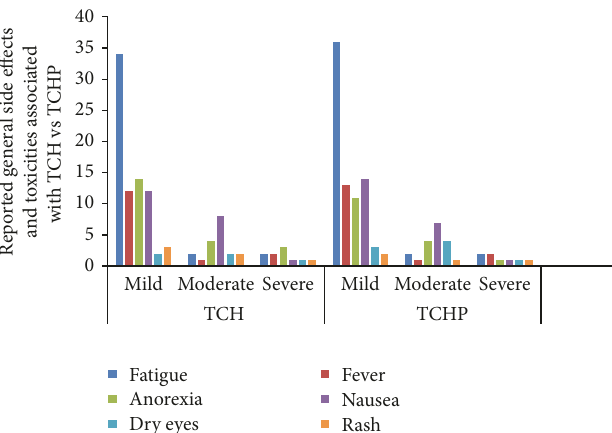
Figure2:ReportedgeneralsideeffectsandtoxicitiesassociatedwithTCH(docetaxel,carboplatin,andtrastuzumab)versusTCHP(docetaxel, carboplatin, trastuzumab, and pertuzumab). The most common toxicities documented in the patient records by severity are shown. Numbers indicate percentages of patients with documented evidence of specific adverse toxicities. The severity of side effects was established according to Common Terminology Criteria for Adverse Events (CTCAE), Version 4.0, June 2010, National Institutes of Health, National Cancer Institute [6]. Mild side effects were classed as CTCAE grade 1, moderate as CTCAE grades 2-3, and severe as CTCAE grade 4 side